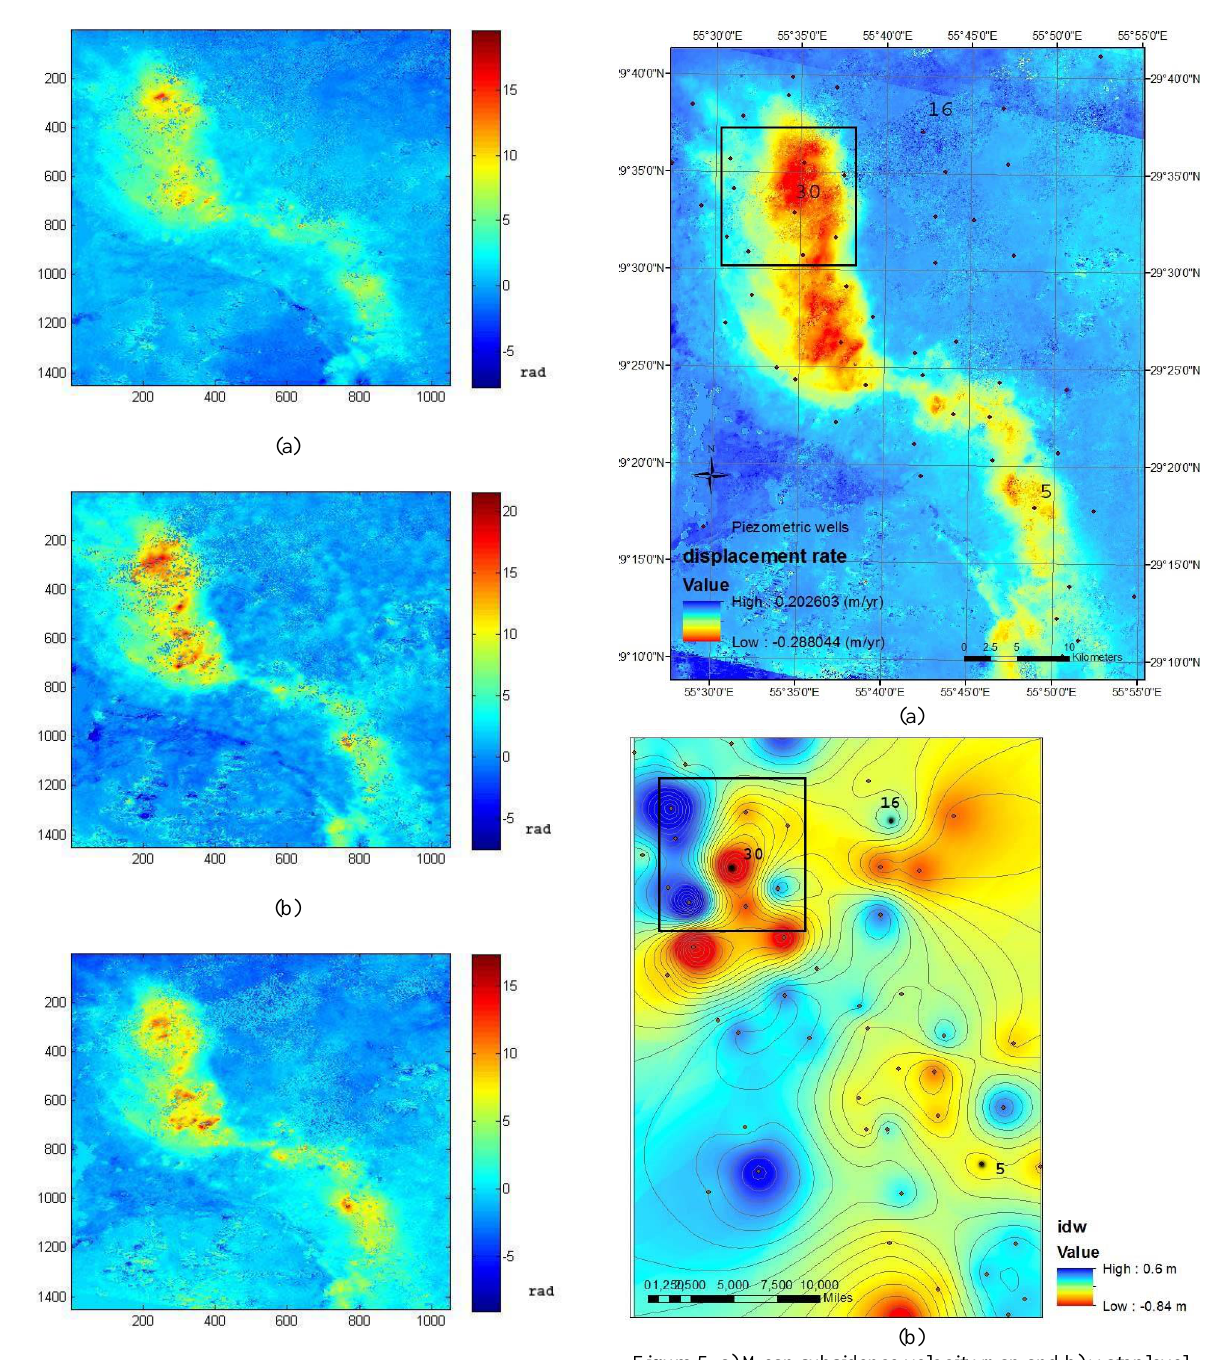
Figure 5. a) Mean subsidence velocity map and b) water level changes in the aquifer system. Piezometric wells 5, 30 and 16 in Figure 4. Processed interferograms with different temporal the middle and outside the subsidence area are baselines a) 2005/03/08-2005/05/17, b) 2005/07/17-2005/08/30 and c) 2006/02/21-2006/06/06.